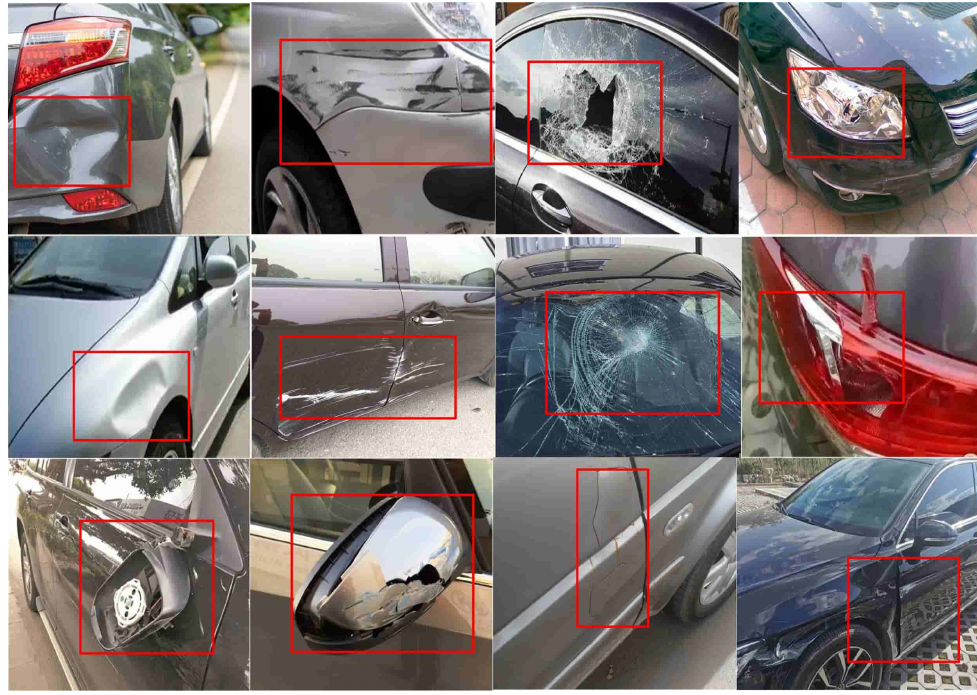
Figure 14. Vehicle exterior damage partial pictures.